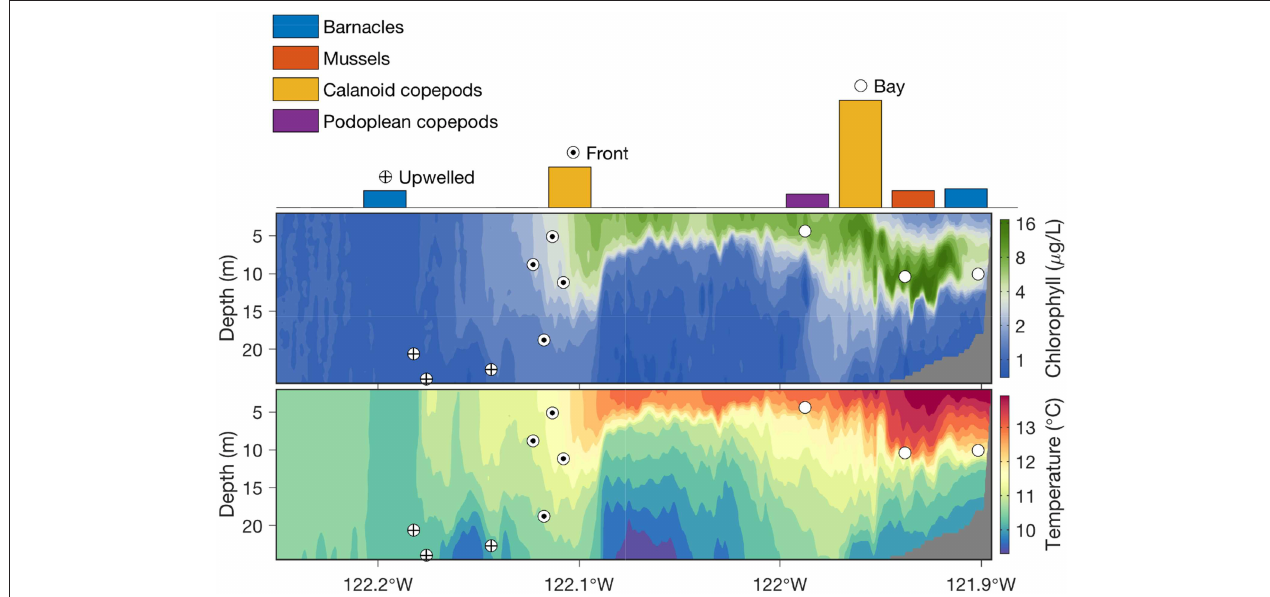
FIGURE 5 | In the 2011 frontal sampling experiment in Monterey Bay, the Dorado AUV flew westward on a 31-km transect along 36.9 ◦ N, on a yo-yo trajectory from the surface to 25-m depth (except for a shallow-water portion near the east end of the transect). Chlorophyll fluorescence and temperature measured by the AUV are shown in the upper and lower panels, respectively. Locations of where the AUV’s ten gulpers were triggered in the three distinct water columns are marked by the corresponding symbols. Zooplankton abundance in the water samples is shown by color-coded